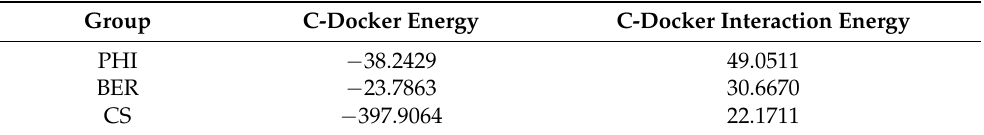
Table 3. Interaction energy of TAS2R 10.